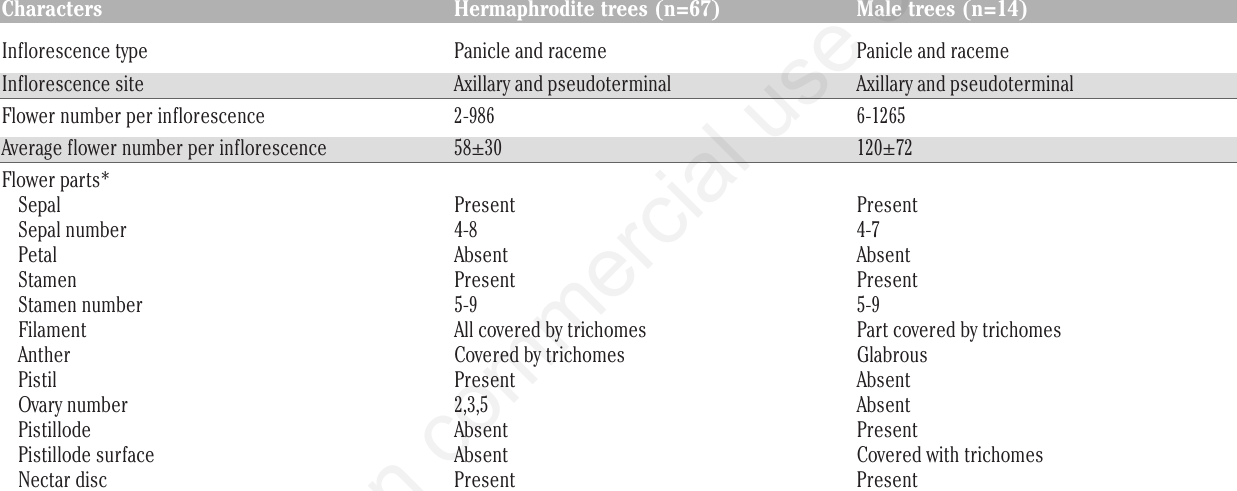
Indonesia).Table 1. The morphological characteristics of flowers on hermaphrodite and male pulasan